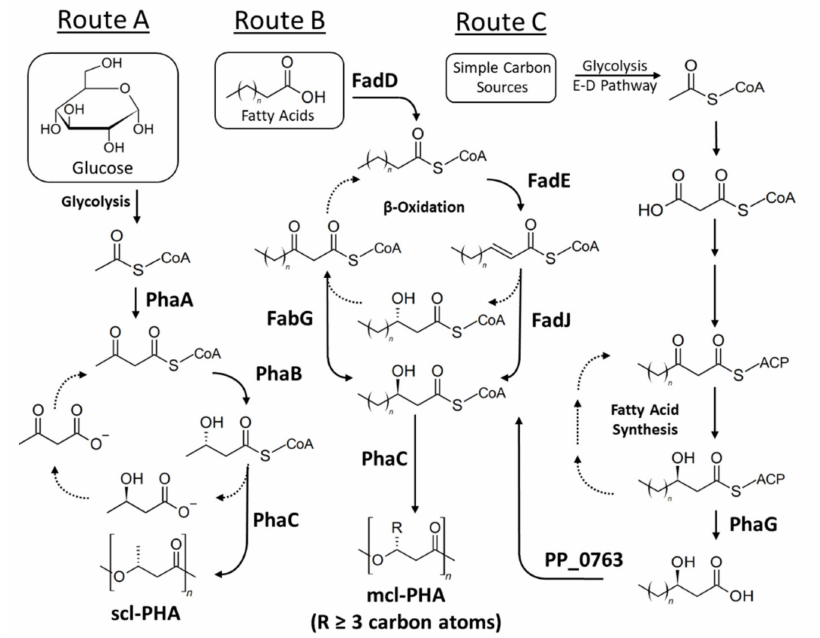
Figure 2. Metabolic routes for PHA